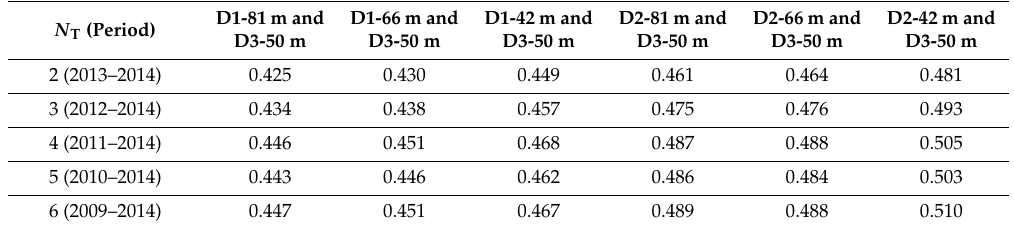
Table 3. Squared Pearson correlation ( r 2 ) between data from D1 or D2 at di ff erent heights and di ff erent wind monitoring campaign lengths in combination with data from D3.